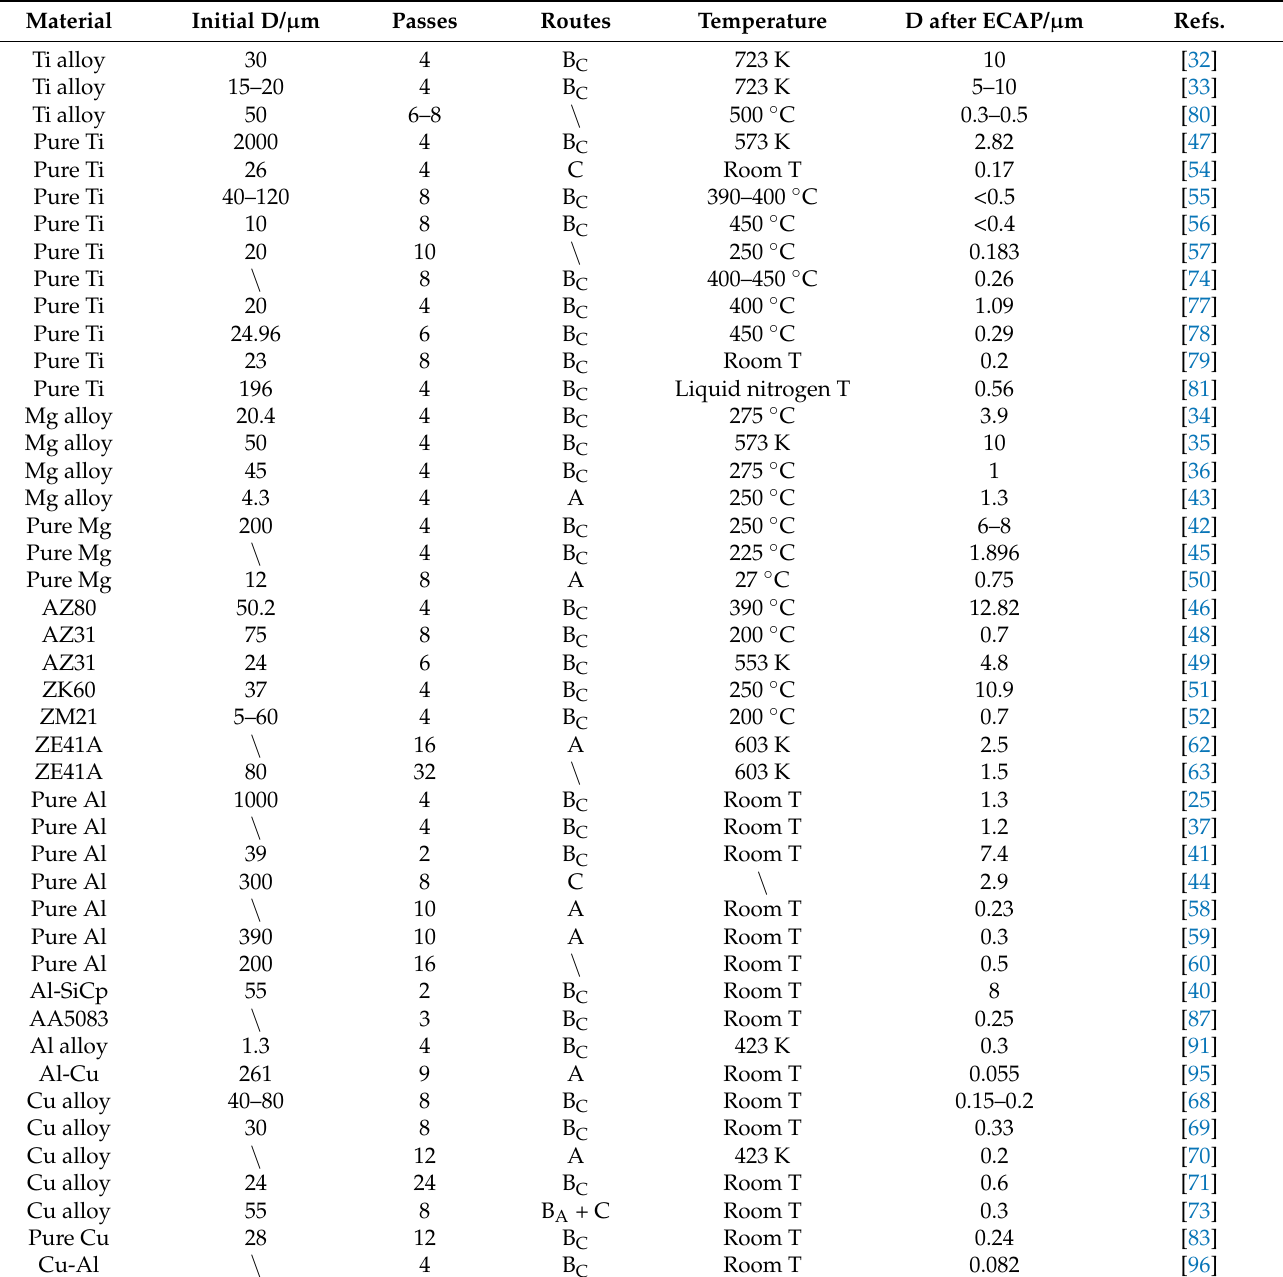
Table 1. Effects of ECAP parameters on the grain size